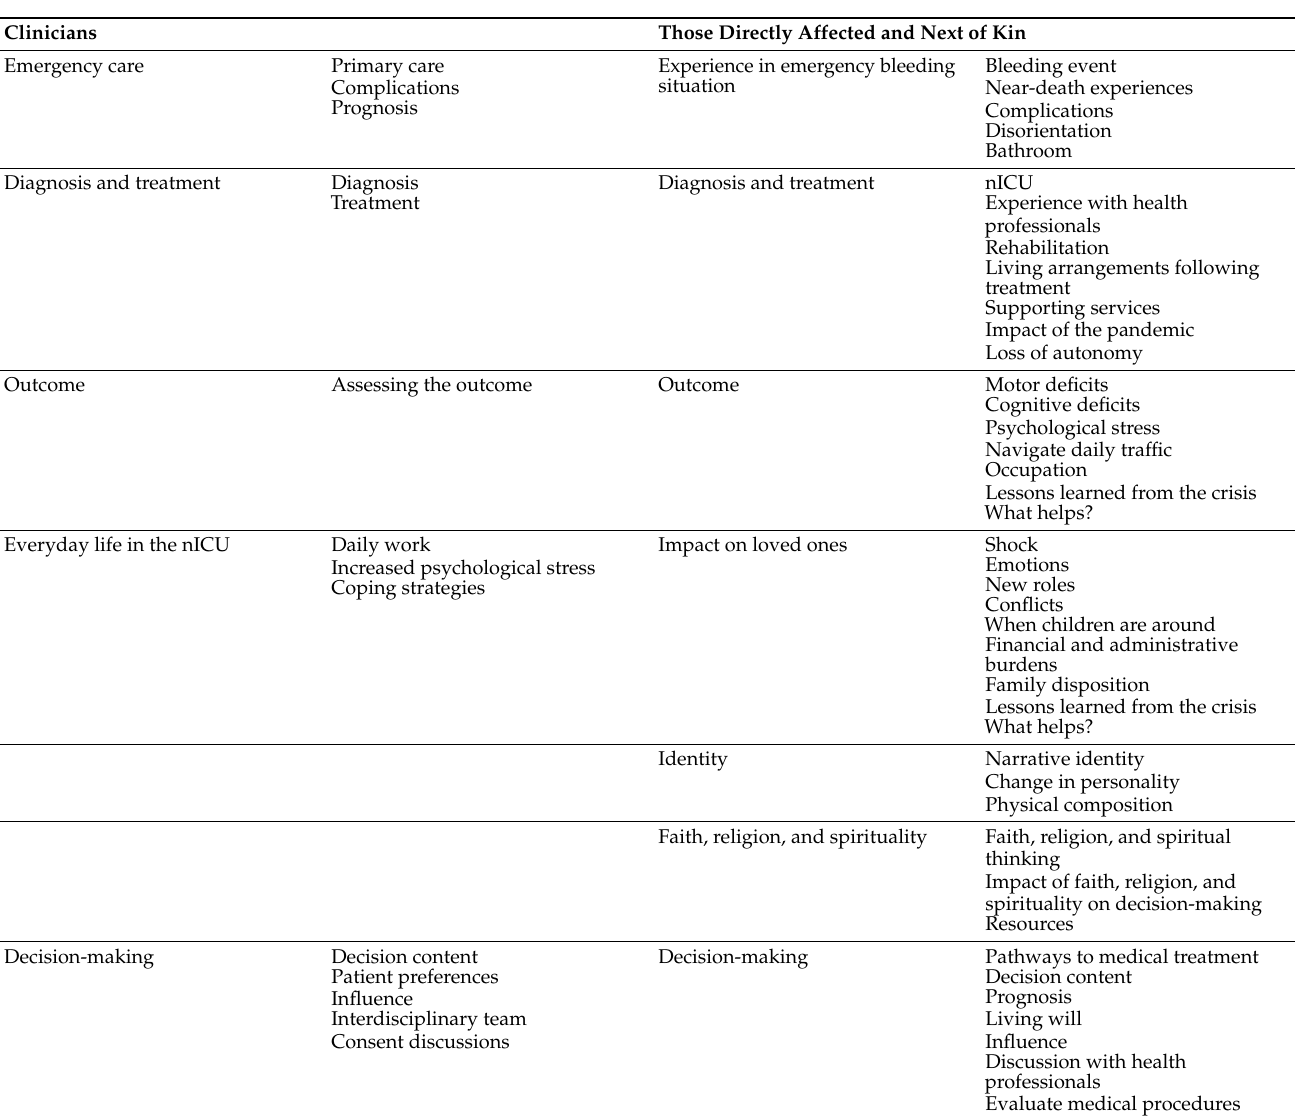
Table 3. Thematic focus on themes emerging from the interviews, divided into main categories (gray) and subcategories